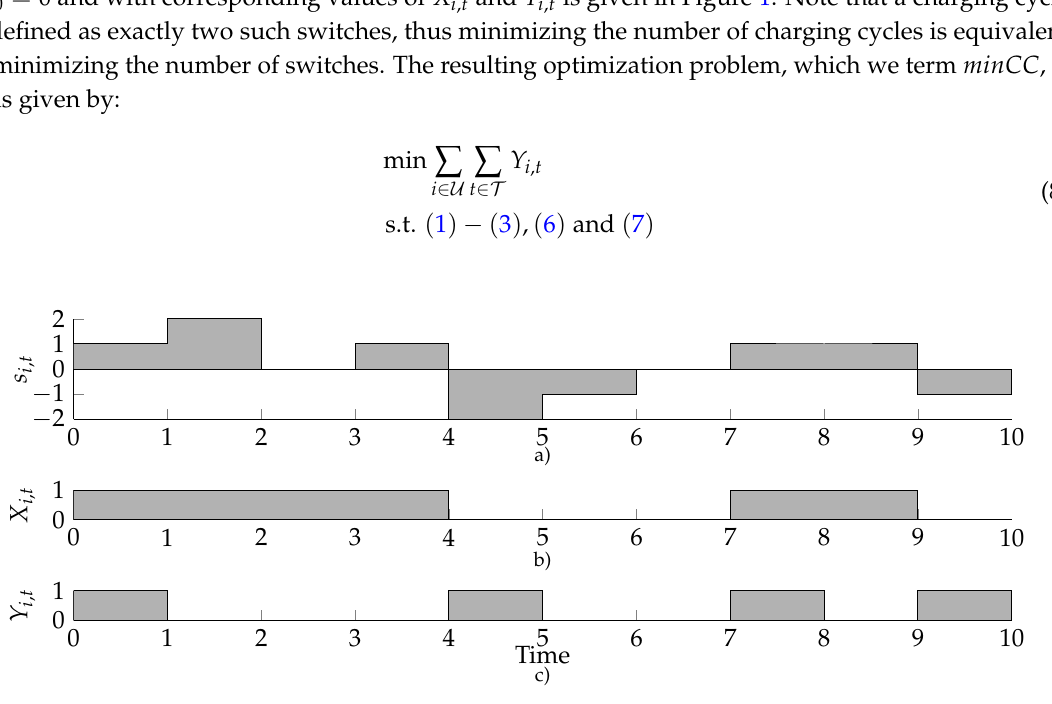
Figure 1. An example of the flow s i , t into and from a storage device i with X i ,0 = 0 for 10 time intervals in ( a ), with corresponding values of X i , t and Y i , t in ( b ) and ( c ),